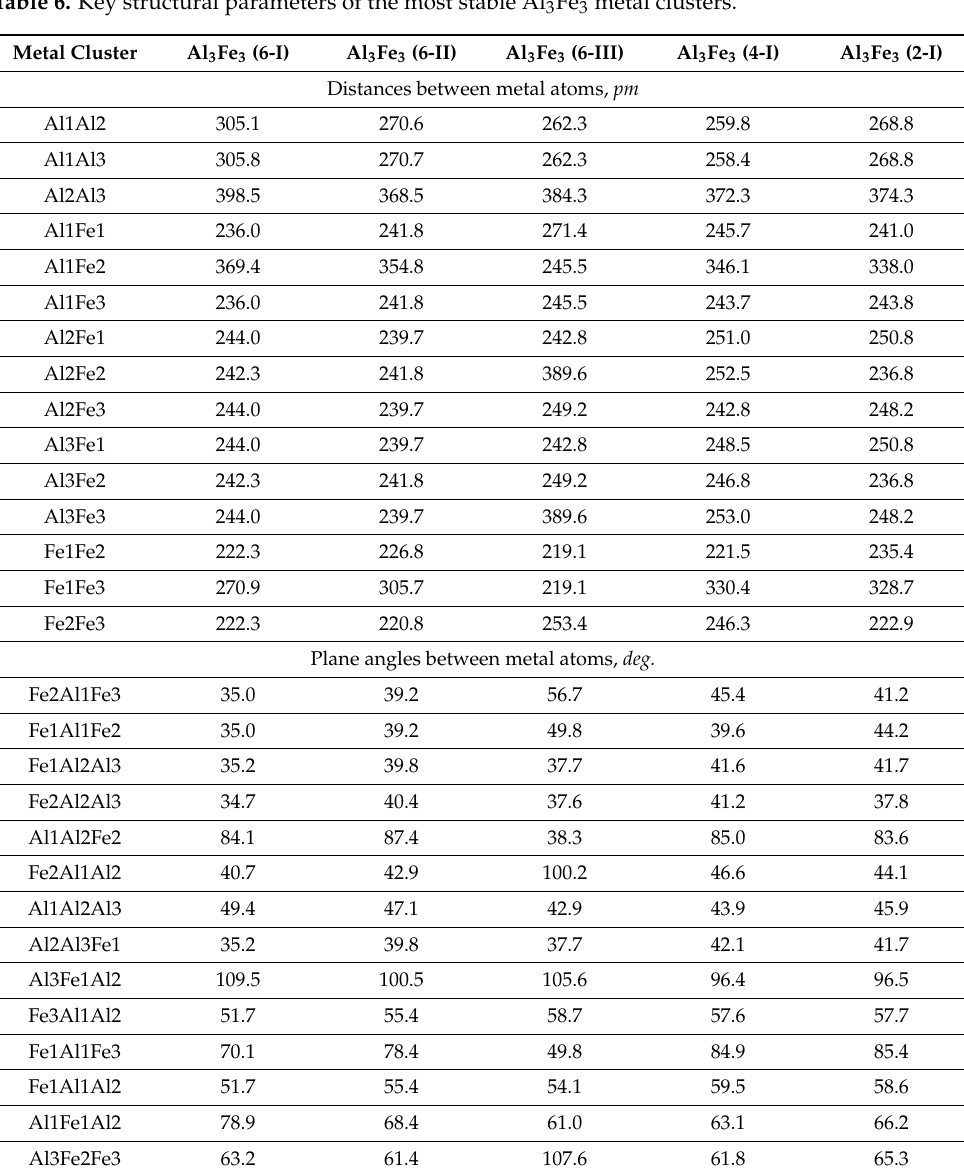
Table 6. Key structural parameters of the most stable Al 3 Fe 3 metal